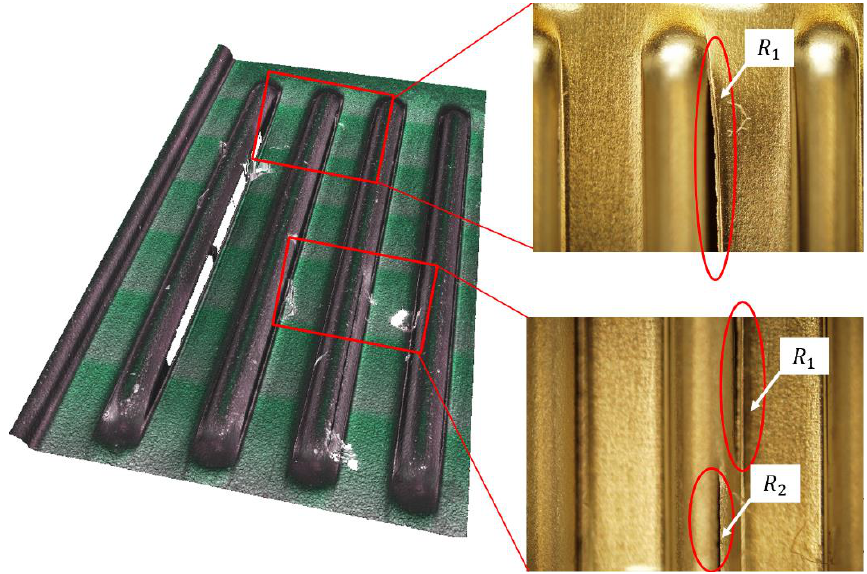
Figure 13. 3D surface scan performed on micro-stamping condition 4.28 with an Alicona surface profilometer (left image), the right two images were obtained from an optical microscope.